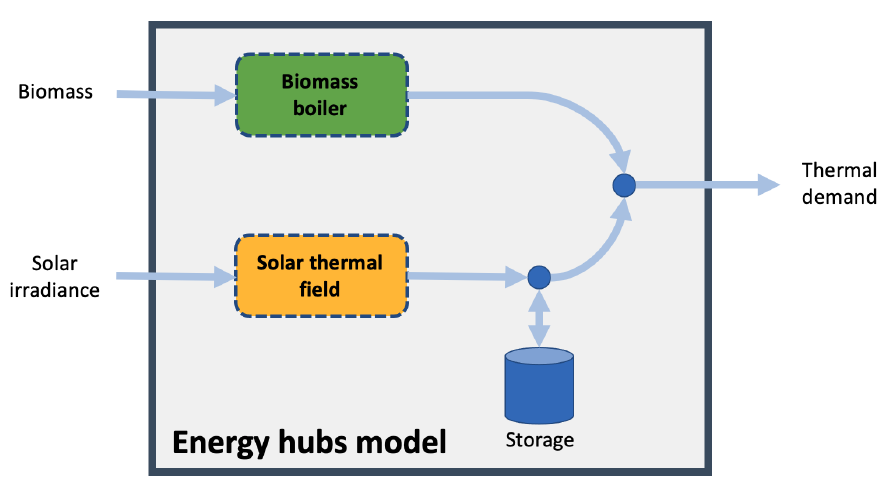
Figure 2. The Energy Hubs (EH) schematic diagram from which the mathematical model is